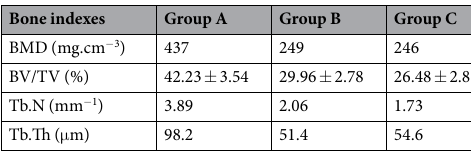
Table 1. Microarchitecture parameters measured by